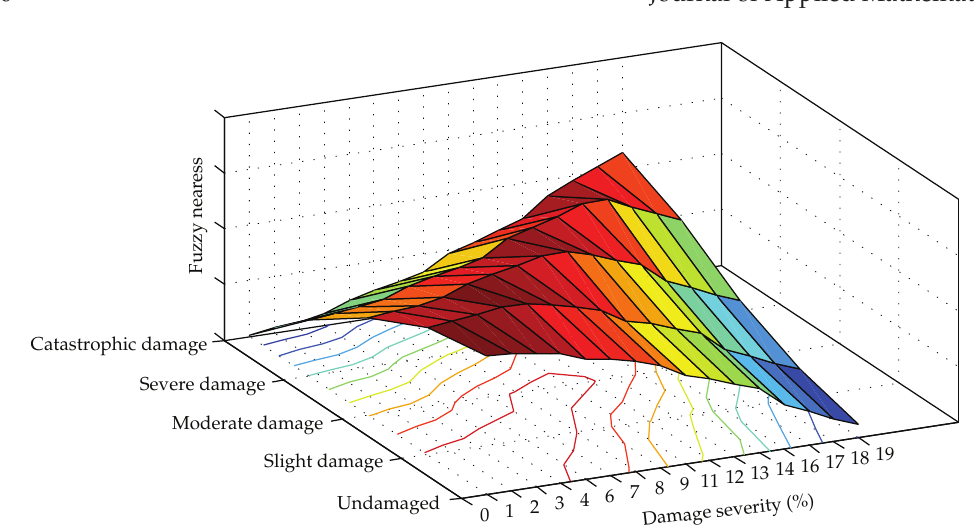
Figure 7: Fuzzy nearnesses between eigenvector of each damage severity and rules in knowledge base.